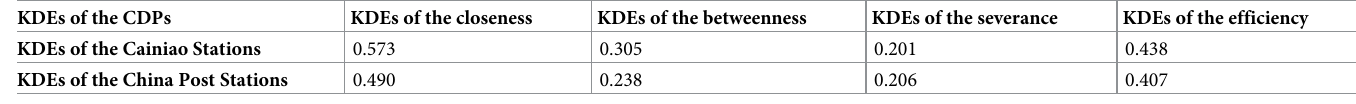
Table 1. Spatial correlation coefficients between street network centralities’ KDEs and